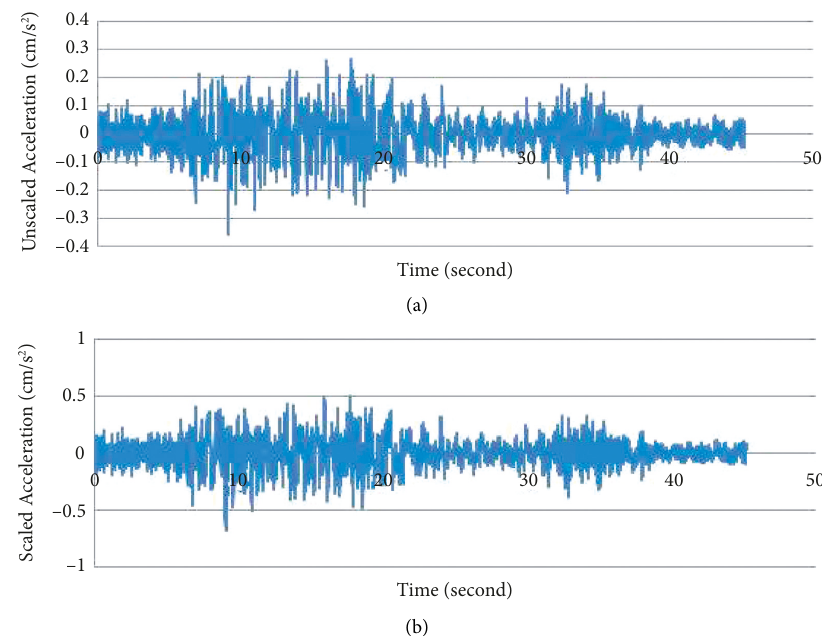
Figure 8: Earthquake with an epicenter at Kayseri-Kocasinan ( M earthquake in the north-south (N-S) route.